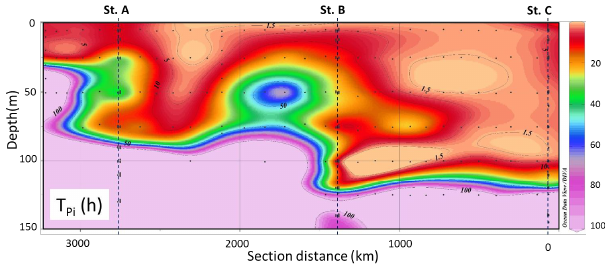
Figure 2. Phosphate turnover time (h) of the bulk community (>0.2µm) over the BOUM cruise